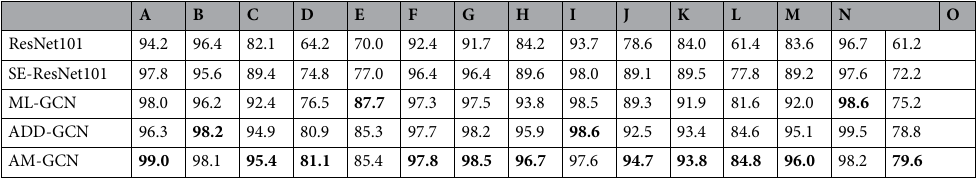
CF1, OF1, CP, CR, OP, and OR of 94.67%, 93.16%, 95.07%, 94.27%, 93.07%, and 93.26%, respectively. Compared with ML-GCN that uses static graph convolution to model the relationship between labels, ADD-GCN uses